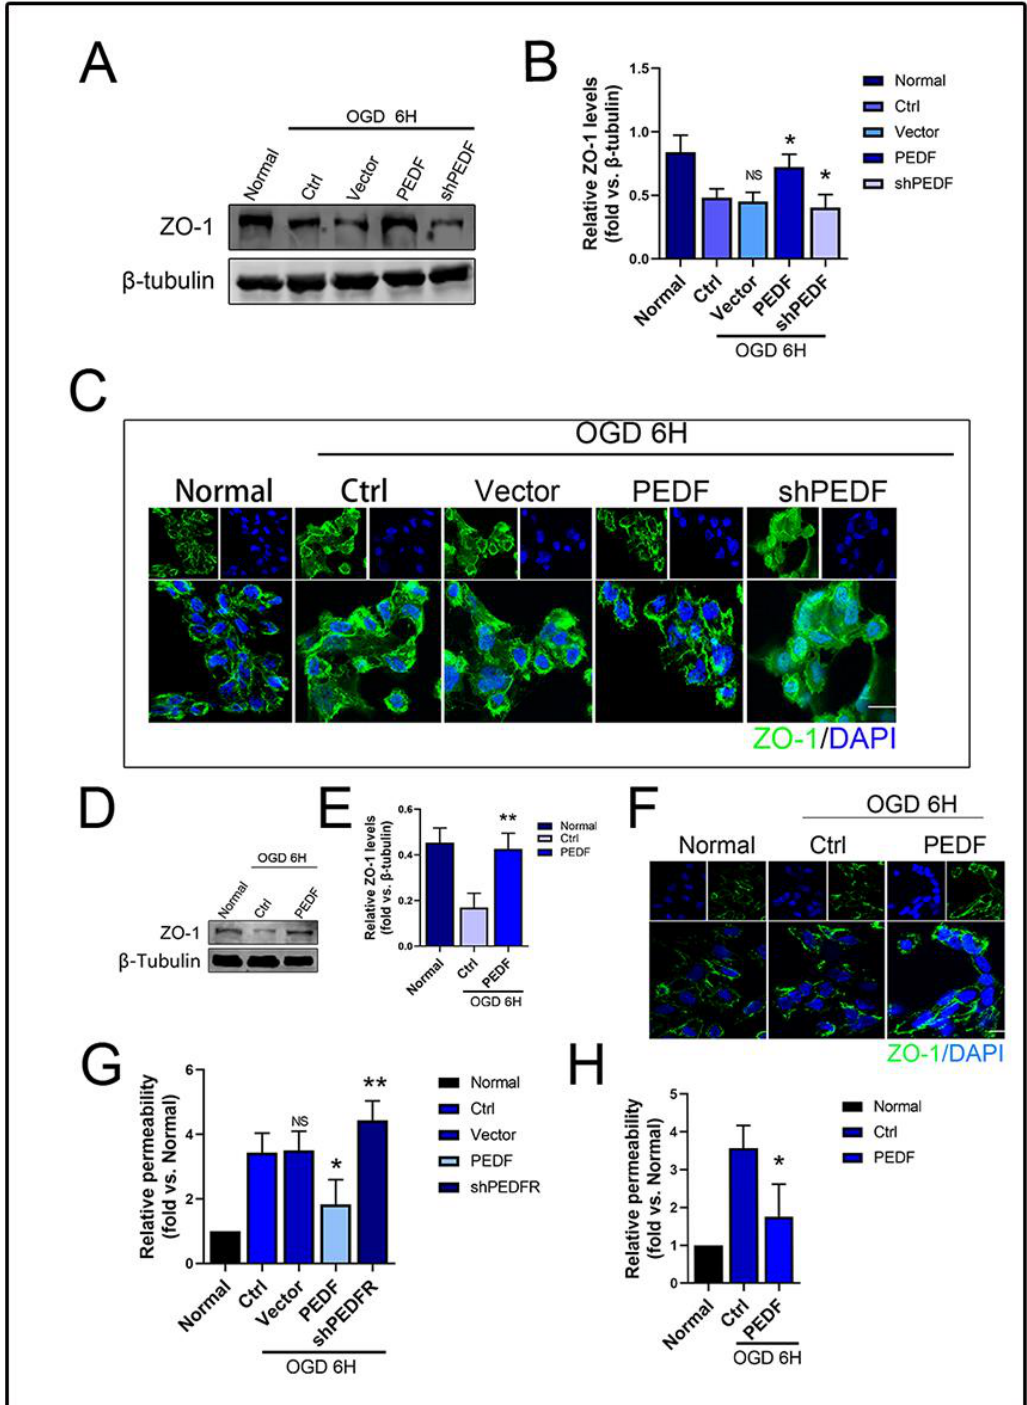
Figure 2. The effect of PEDF on the permeability of HUVECs during OGD. ( A , B ) Western blotting to detect the effect of PEDF on the expression of ZO-1 in vivo. ( C ) Immunofluorescence to observe the effect of PEDF on the distribution of ZO-1 in vivo. Scale Bar = 200 µ m. ( D , E ) Western blotting to detect the effect of PEDF on the expression of ZO-1 in vitro. ( F ) Immunofluorescence to observe the effect of PEDF on the distribution of ZO-1 in vitro. Scale Bar = 200 µ m ( G , H ) Quantification of the effect of PEDF on endothelial cell permeability. Data are expressed as mean ± SD; n = 4; NS, no significant difference; * p < 0.05; ** p < 0.01.